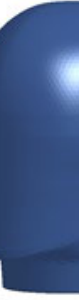
Table 2. Details of the finite element model of the headform and anvils.